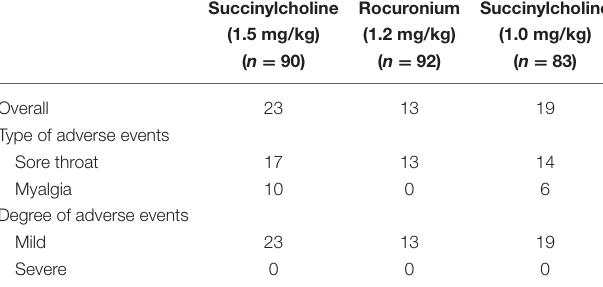
TABLE 3 | Adverse